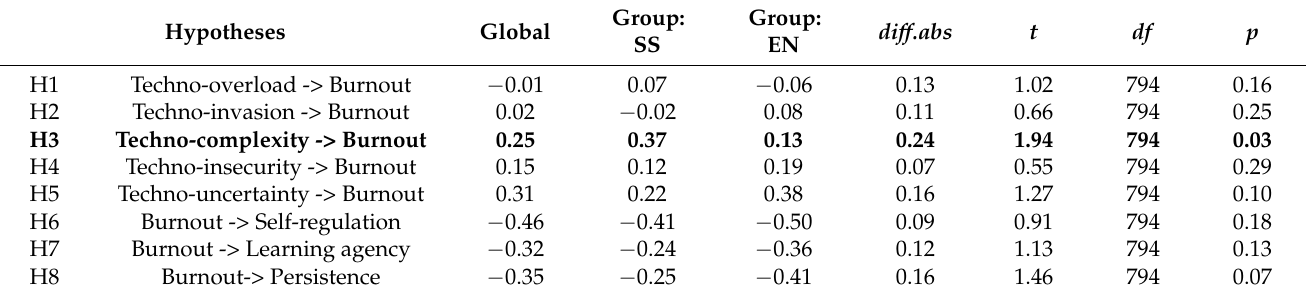
Table 5. Comparison between students from social sciences ( N = 334) and engineering and natural sciences ( N = 462). Hypotheses